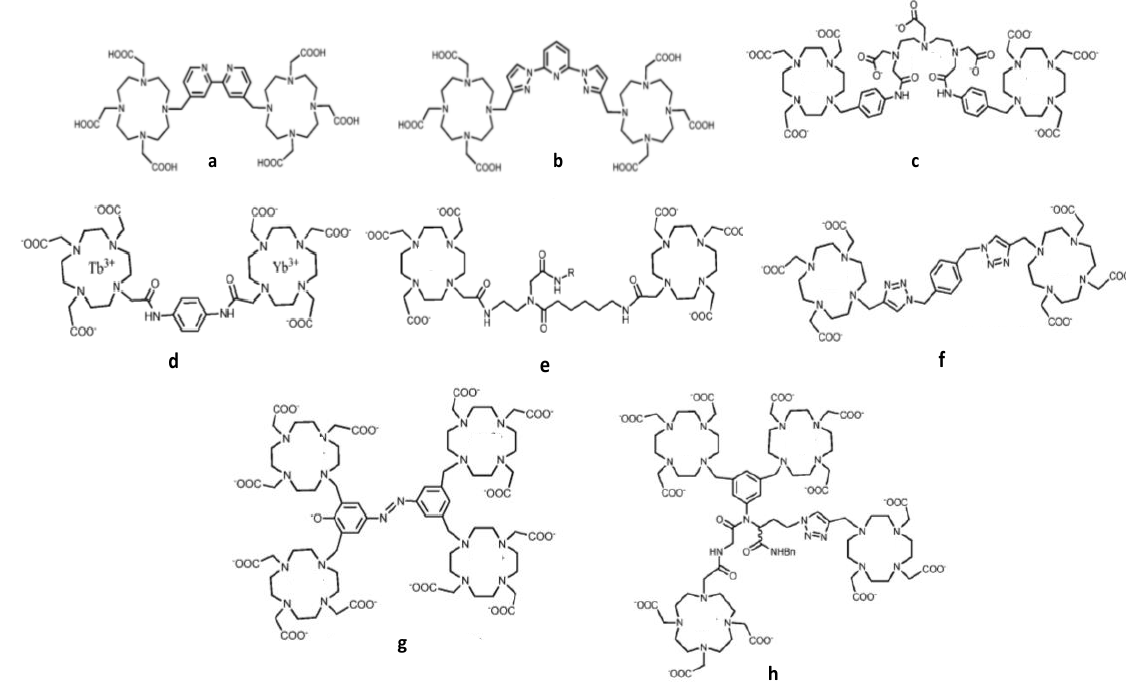
Figure 15. Structures of DOTA-based ligands used to chelate both paramagnetic and luminescent lanthanides for bimodal molecular imaging probes.